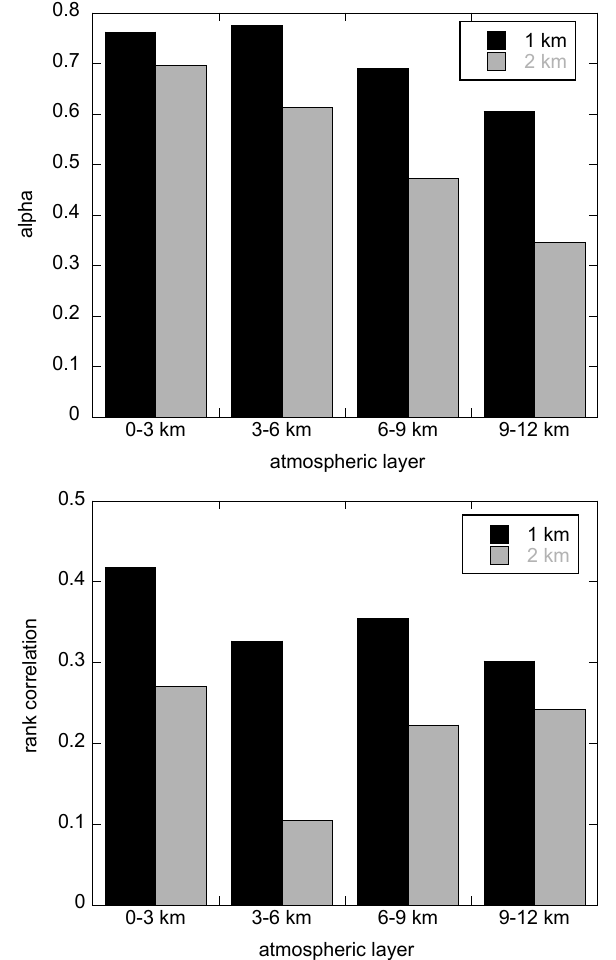
Fig. 5. Alphas (top) and rank correlations (bottom) for the 150km segment size and separation distances of 1 and 2km when ensemble-averaged separately within four different 3km thick at- mospheric layers. 0–3km corresponds to the atmospheric layer closer to the